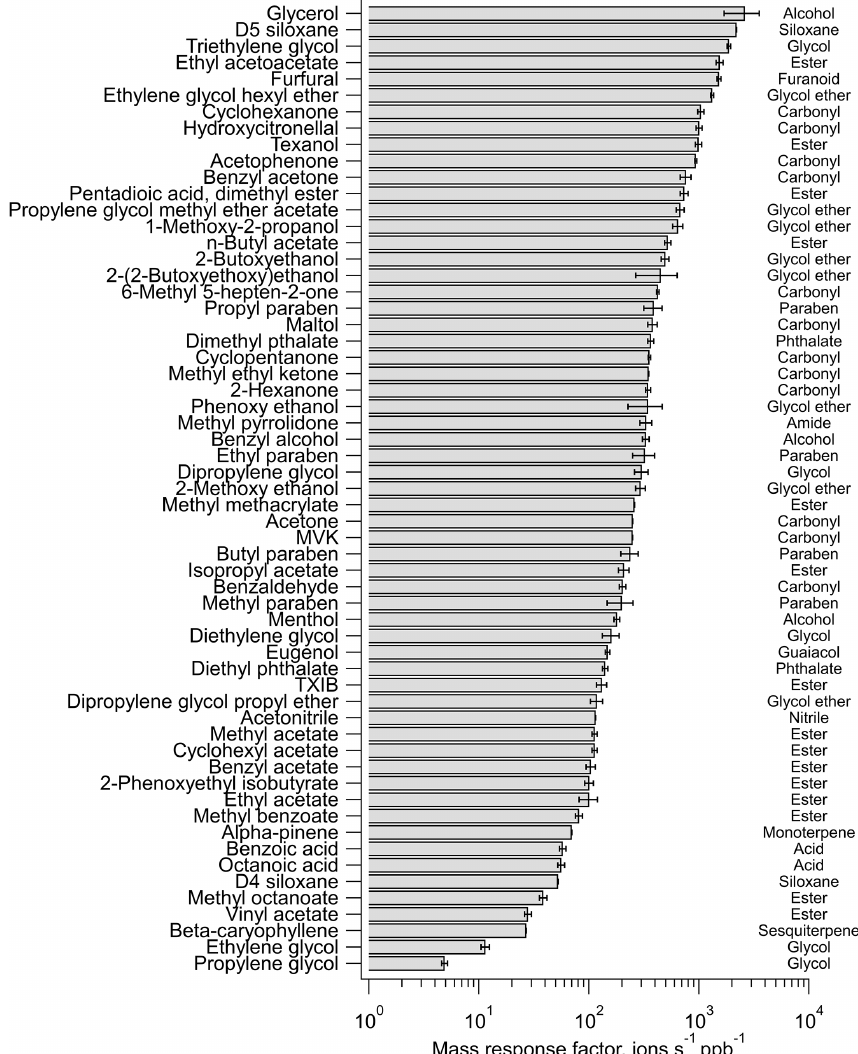
+ ionization toward select calibration standards containing a diverse range of chemical 4